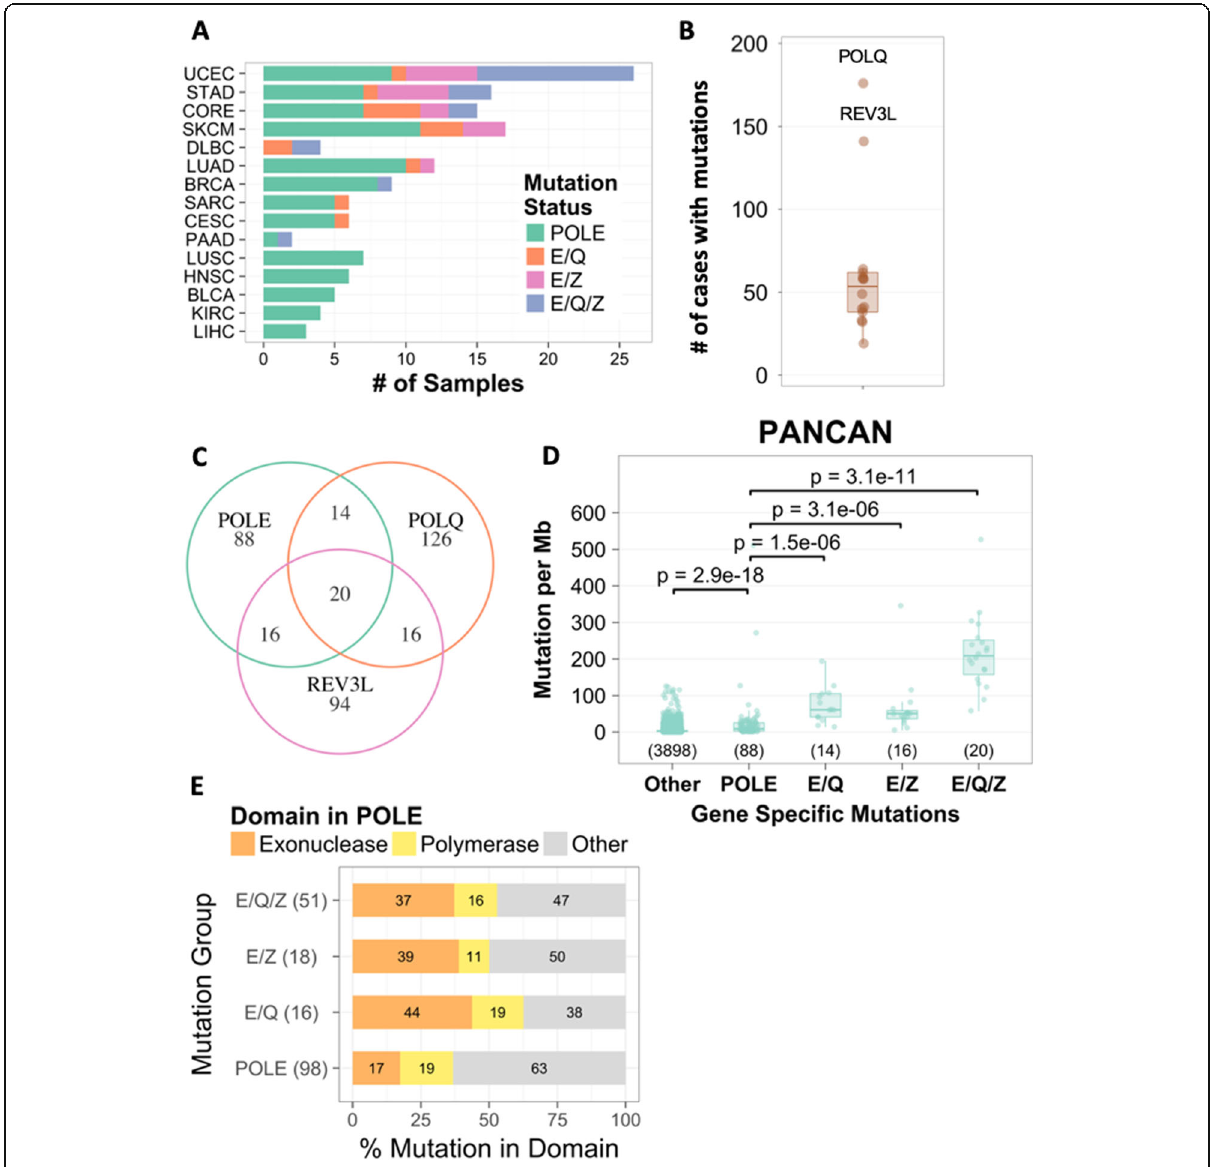
Fig. 1 Cancer types (PANCAN) with POLE/Q/Z mutations in TCGA. a Number of cases with POLE- only , E/Q , E/Z and E/Q/Z mutations in 15 cancer types (cohort referred to as PANCAN) within TCGA. The x-axis shows the actual number of cases with POLE (green), E/Q (orange), E/Z (pink) and E/ Q/Z (blue) mutations. The y-axis displays the 15 cancer types: Uterine corpus endometrial carcinoma (UCEC), Stomach adenocarcinoma (STAD), Colon and rectum adenocarcinoma [38], Skin cutaneous melanoma (SKCM), Lymphoid Neoplasm Diffuse Large B-cell Lymphoma (DLBC), Lung adenocarcinoma (LUAD), Breast invasive carcinoma (BRCA), Sarcoma (SARC), Cervical squamous cell carcinoma and endocervical adenocarcinoma (CESC), Pancreatic adenocarcinoma (PAAD), Lung squamous cell carcinoma (LUSC), Head and neck squamous cell carcinoma (HNSC), Bladder urothelial carcinoma (BLCA), Kidney renal clear cell carcinoma (KIRC), and Liver hepatocellular carcinoma (LIHC). b Case numbers with mutations in polymerase genes. The number of cases in PANCAN with mutations in the following polymerases is displayed on the Y-axis: DNTT, POLA1, POLB, POLD1, POLG, POLH, POLI, POLK, POLL, POLM, POLN, POLQ, REV1, REV3L. c Venn diagram displaying the number of cases in PANCAN with mutations in 1, 2 or 3 POL genes. d Mutations per Mb (y-axis) of PANCAN cases without POLE mutations (other) or with POLE , E/Q , E/Z and E/Q/Z (x-axis) mutations. Number of cases in each group are listed in parenthesis. e Mutation frequencies in POLE exonuclease and polymerase domains as a percentage of total number of mutations in the POLE exome. “ Other ” refers mutations in the entire Exome outside the exonuclease or polymerase domains. The cases are grouped by their polymerase mutation status on the y-axis, and the number in parenthesis represents the total number of POLE mutations within each